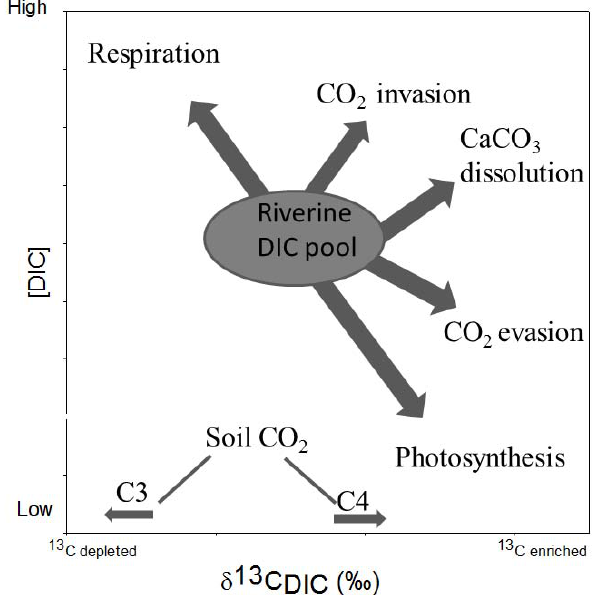
Fig. 1. Conceptual model showing the main watershed and in- stream biogeochemical processes controlling riverine DIC concen- tration and δ 13 C DIC